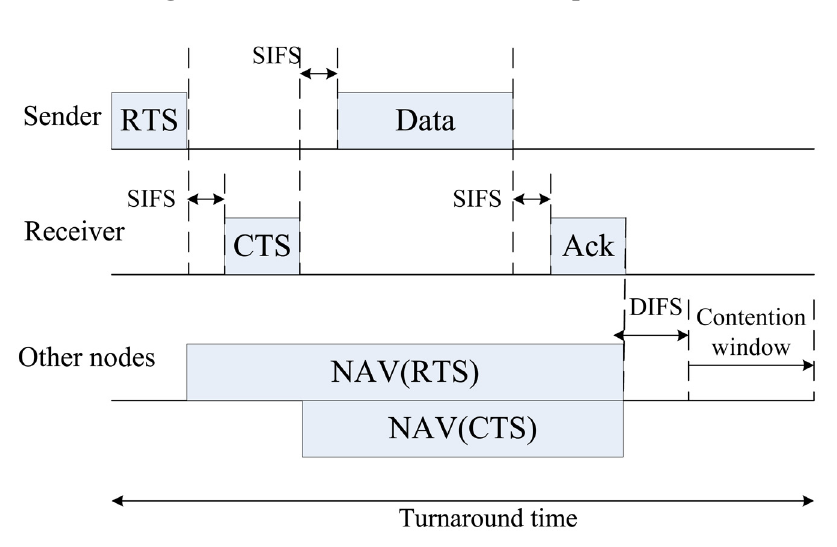
Figure 2. DCF mode in CSMA/CA